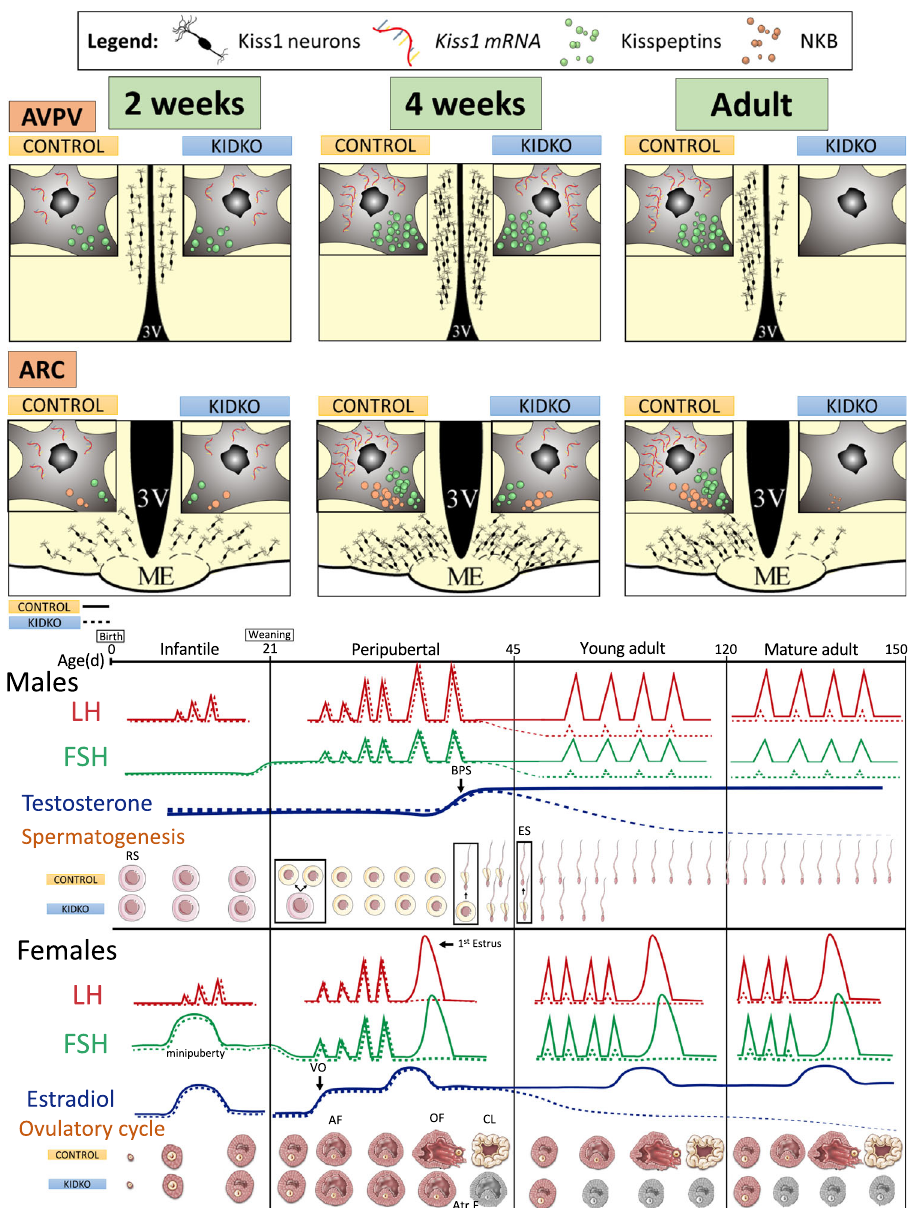
Fig. 8 | Major neuroendocrine and phenotypic alterations after conditional ablationofDicerinKiss1. Agraphicalsummaryofthemajorchangesoccurringin KiDKO mice is presented. In addition to changes in the number/survival of Kiss1 neurons,aswellasexpressionof Kiss1 ,kisspeptinandNKB,intheAVPVandARCof